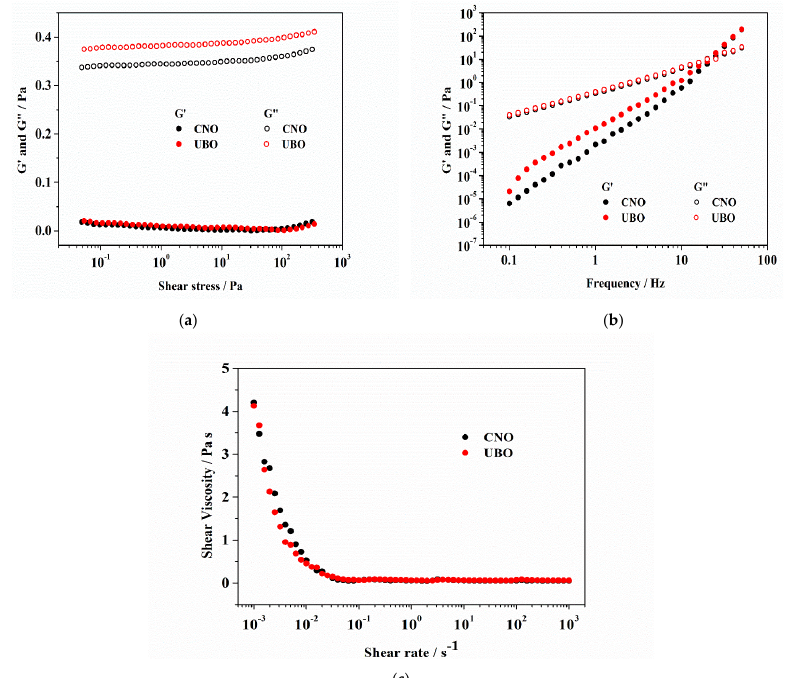
Figure 2. Stress sweeps for oil samples: CNO and UBO ( a ); frequency sweeps of CNO and UBO ( b ), where G’—storage modulus (represented as filled symbols) and G”— loss modulus (evidenced as empty symbols); Flow curves of CNO and UBO, at 25 °C ( c ).